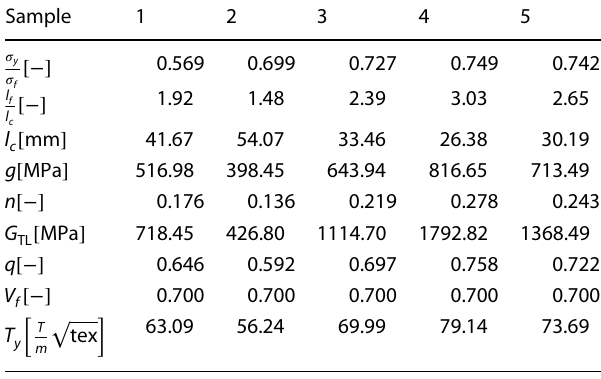
Table 9 Critical length of yarn samples 1–5 and according param- eters